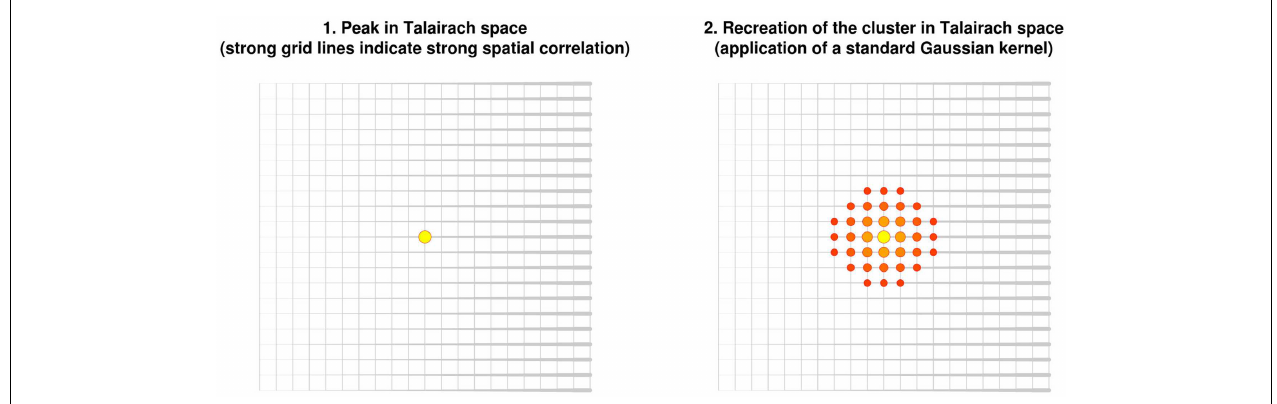
effect size (or the estimation of the activation likelihood) does not depend on the strength of the spatial correlations, but only on the Euclidean distance between each voxel and the peak.